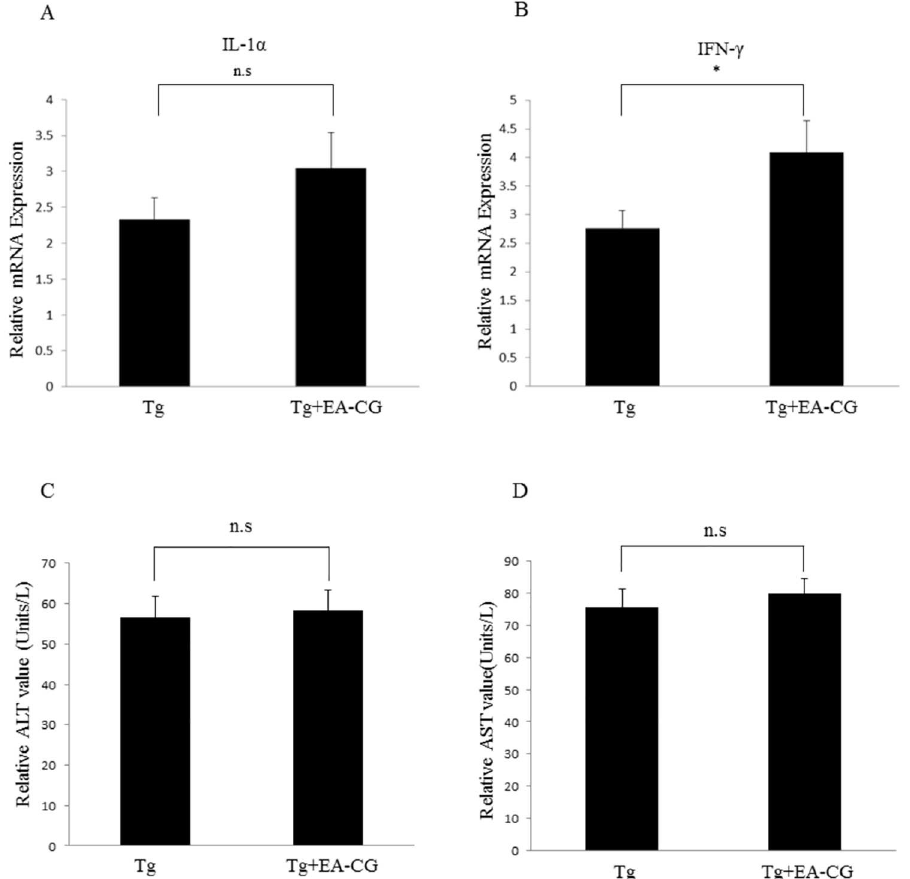
Fig 3. Effect of CG extractson liver toxicity using aspartate/alanine aminotransferaseactivity in Tg mice. The Mo/Hu APPswe PS1dE9 mice were fed with or without EA-CG (50 mg/kg BW) for 6 months. The brain were isolated from the EA-CG treated and control (PBS) groups (n = 3 mice per each group). After the brain was dividedin half, we tested the gene expressionprofile of the inflammatory cytokines IL-1 α (A) and IFN- γ (B) as markers of the cellularresponse by semi-quantitative RT-PCR. The fold change was presented after normalization to the housekeeping gene β -actin). * p < 0.05; n.s. mean not significant.The levels of Aspartate aminotransferase activity (AST, Units/L) and Alanineaminotransferase activity (ALT, Units/L)) were measuredin the sera by centrifugation after obtain mice blood from each group, and then the relativevalue (U/L) of ALT (C) or AST (D) as hepatotoxicity markers were measured and presentedafter comparisonto the controls (PBS groups), accordingto the manufacturer’s instructions. The values were presented as the means ± S.E.M (n = 3 mice per each group). n.s. mean not